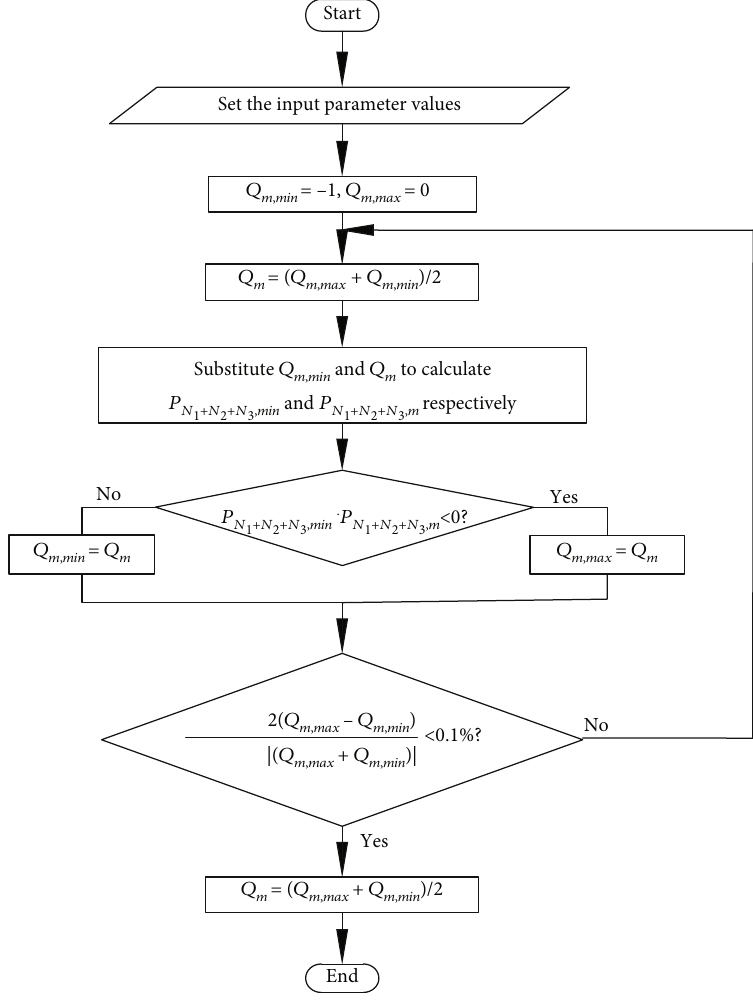
Figure 6: The fl ow chart of the numerical